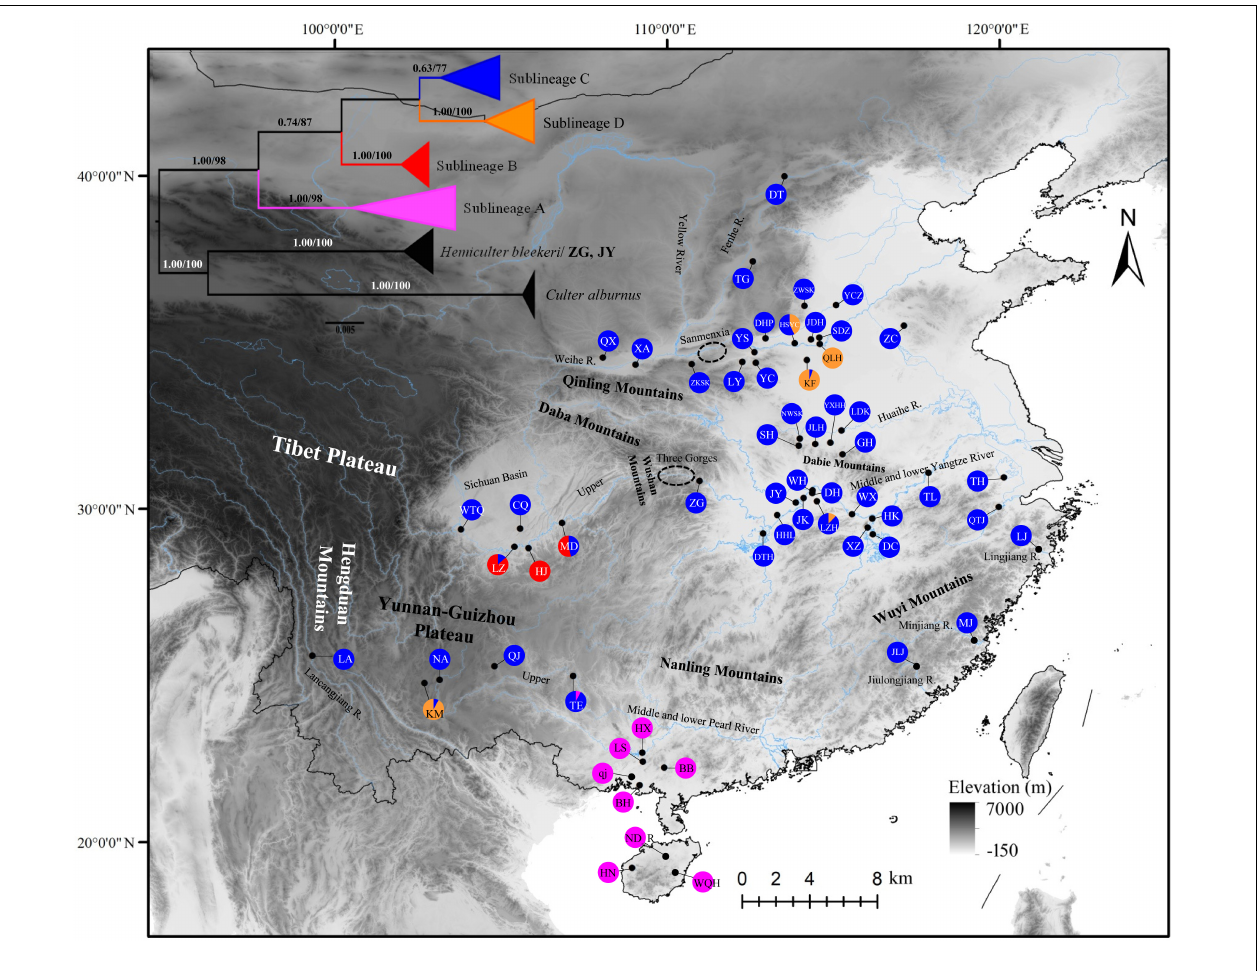
FIGURE 1 | Map of sampling locations of H. leucisculus , most locations in middle stream of Yellow River were cited from Wang L. H. et al., 2021, and all the locations in Yangtze River system and Pearl River system were cited from Chen et al. (2017) and Wang Y. Q. et al. (2021), and the phylogenetic tree based on Bayesian inference (values on branches indicate bootstrap proportions from a maximum likelihood analysis and Bayesian posterior probabilities). Localities are detailed in Supplementary File 1 . Populations are presented as pie charts with slice sizes proportional to the frequency of the four lineages as identified by phylogenetic analysis. Colors correspond to the lineages (purple, sublineage A; red, sublineage B; blue, sublineage C; orange, and sublineage